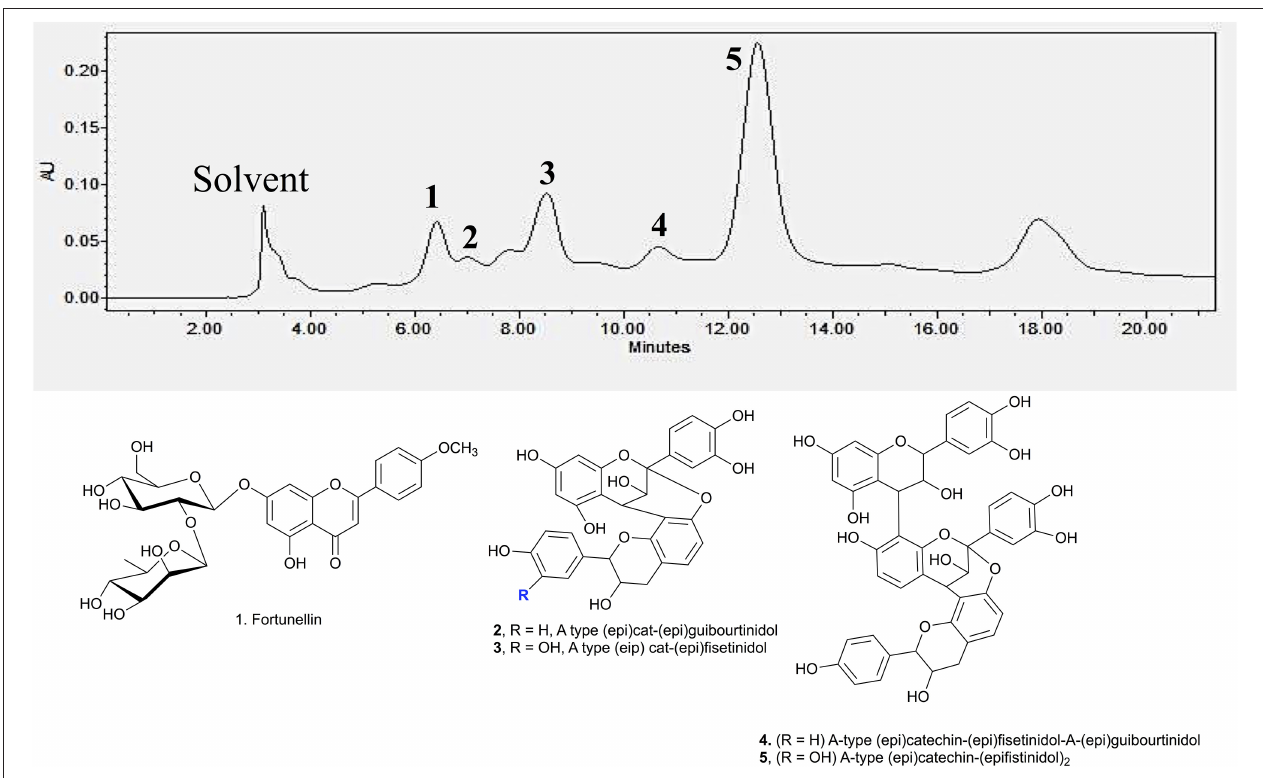
FIGURE 2 | Fragmentation pattern of MS(n) for peak 3 at